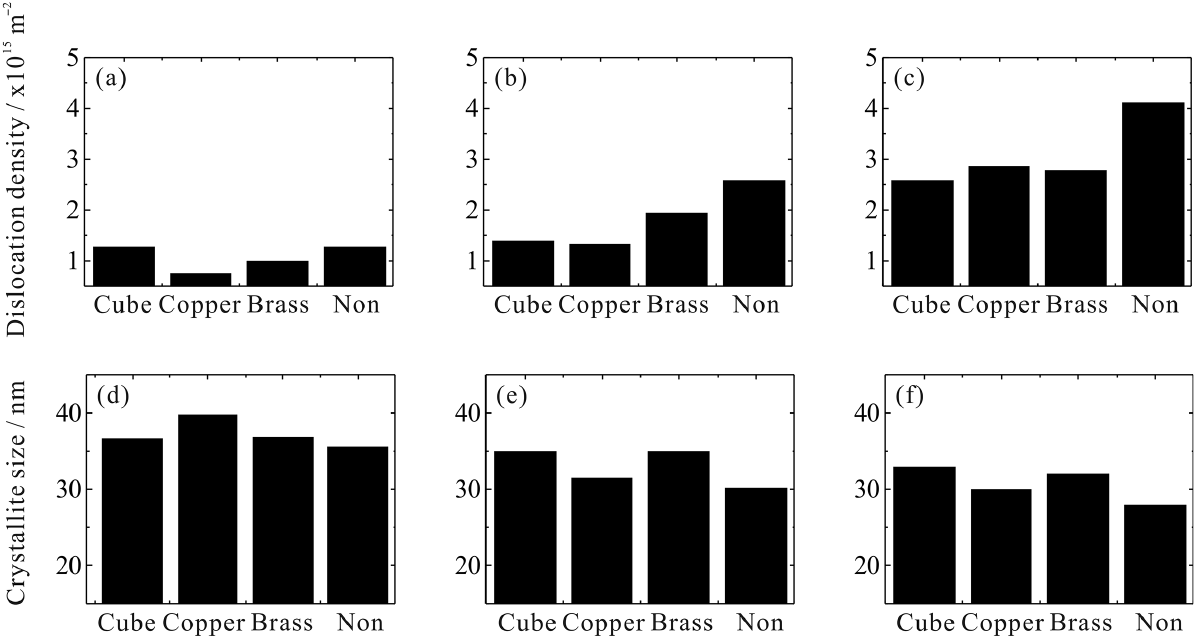
Figure 9: (a) – (c) Dislocation density and (d) – (f) crystallite size for texture and non-texture components of the cold-rolled copper sheets at rolling reductions of (a) and (d) 30, (b) and (e) 50, and (c) and (f)